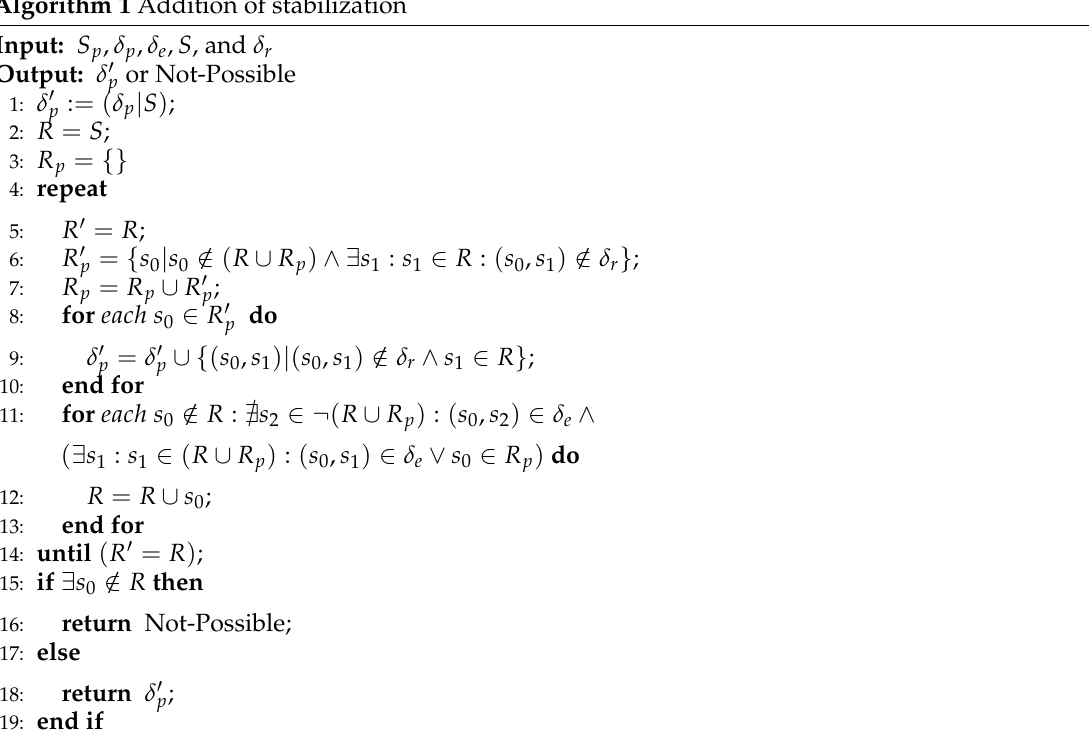
Algorithm 1 Addition of